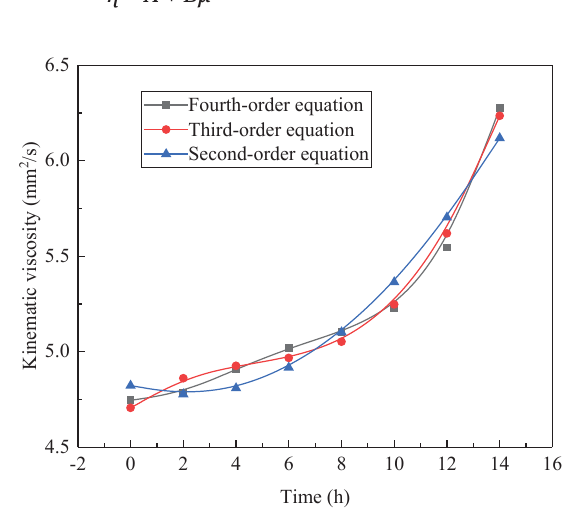
Figure 4: Curve fitting of kinematic viscosity and oxidation time of Jatropha curcas biodiesel.